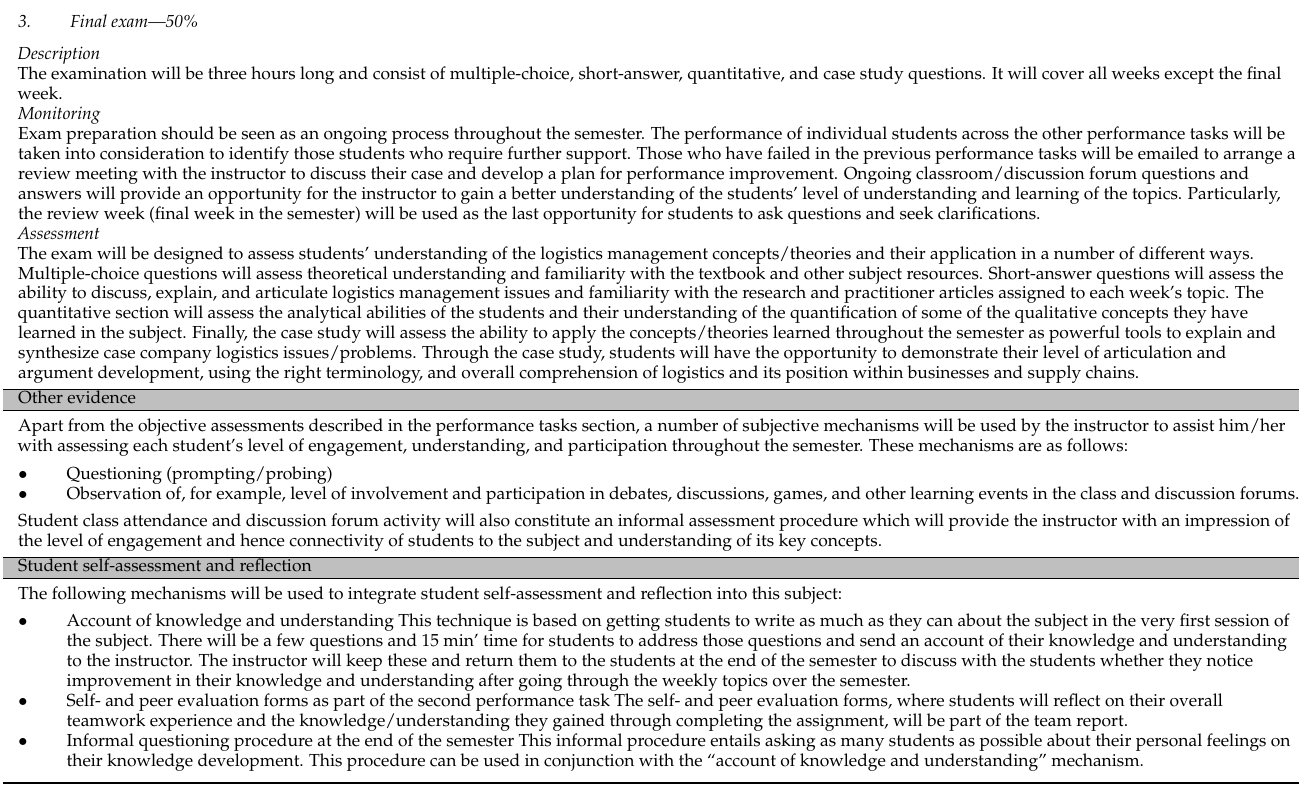
Table 3. Teaching Plan Stage 3—Plan learning